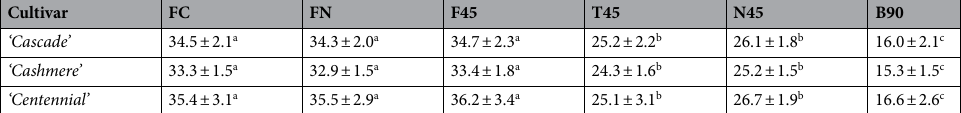
Table 2. Mean internode length (cm) of main bine internodes between node 20 and 40. Control free to climb twine at 90° (FC), free to climb netting at 90° netting (FN), free to climb twine at 45° (F45), touch stimuli on twine at 45° slope (T45), touch stimuli on netting at 45° slope (N45), and touch stimuli plus 90° internode bending on netting at a 45° mean slope (B90). Standard deviation terms are reported as standard deviation of the difference of the means for replicates of cultivars ‘Cascade’ (n = 6), ‘Centennial’ (n = 6), and ‘Cashmere’ (n = 6). Different letters indicate significant differences among treatments ( P <